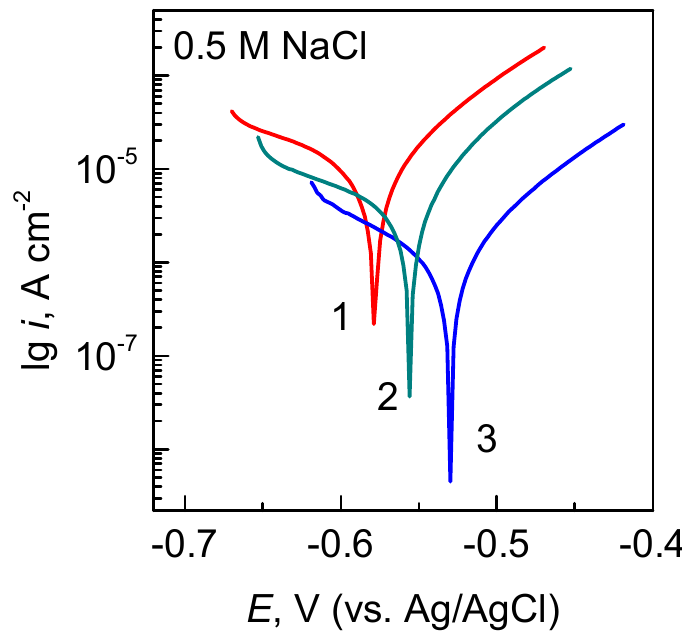
Table 2. The electrochemical parameters and protection efficiency ( P %) of conversion coatings determined in 0.5 M NaCl solution.